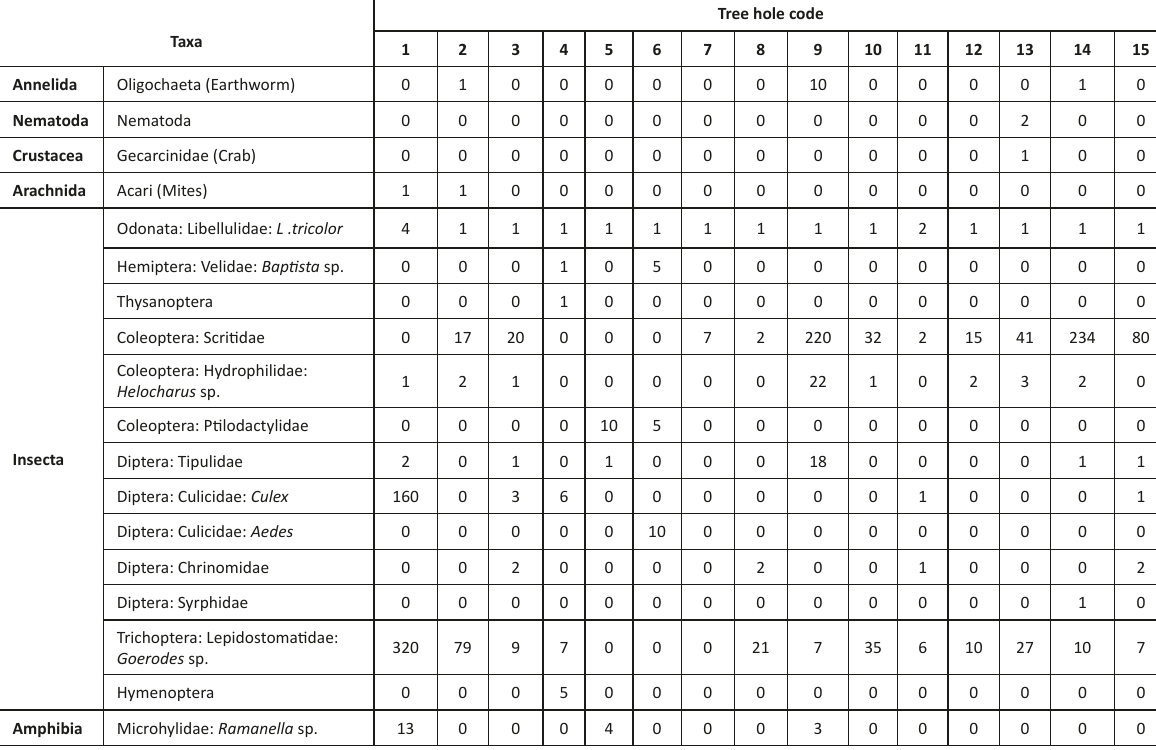
Table 6. Number of Individuals of invertebrates and vertebrates in tree